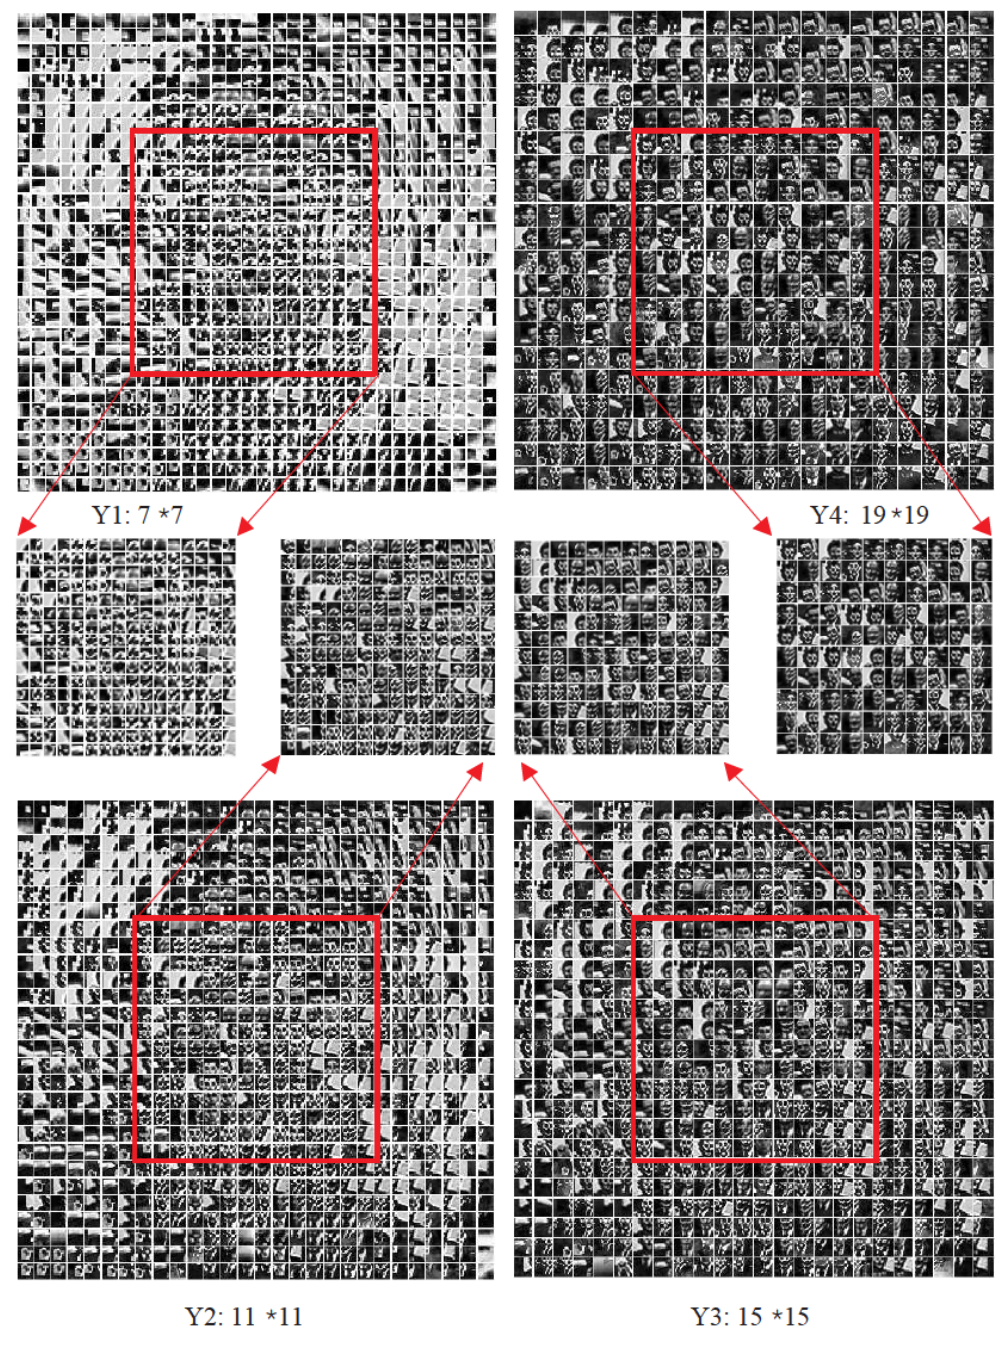
Figure 4: Visualization of the Weight Value from X Layer to Y